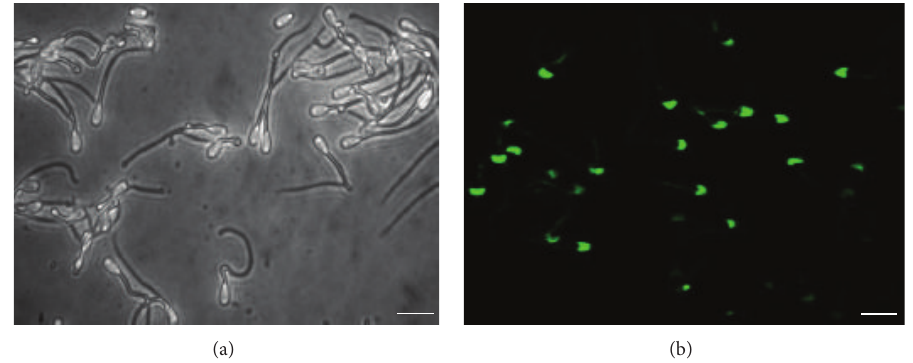
Figure 6: Immunofluorescence localization of the TEX101 protein. Matched phase contrast (a) and fluorescence (b) photomicrographs of permeabilized bovine cauda spermatozoa immunostained with anti-TEX101 polyclonal antibody. Staining was present on the head. Bar represents 10 𝜇